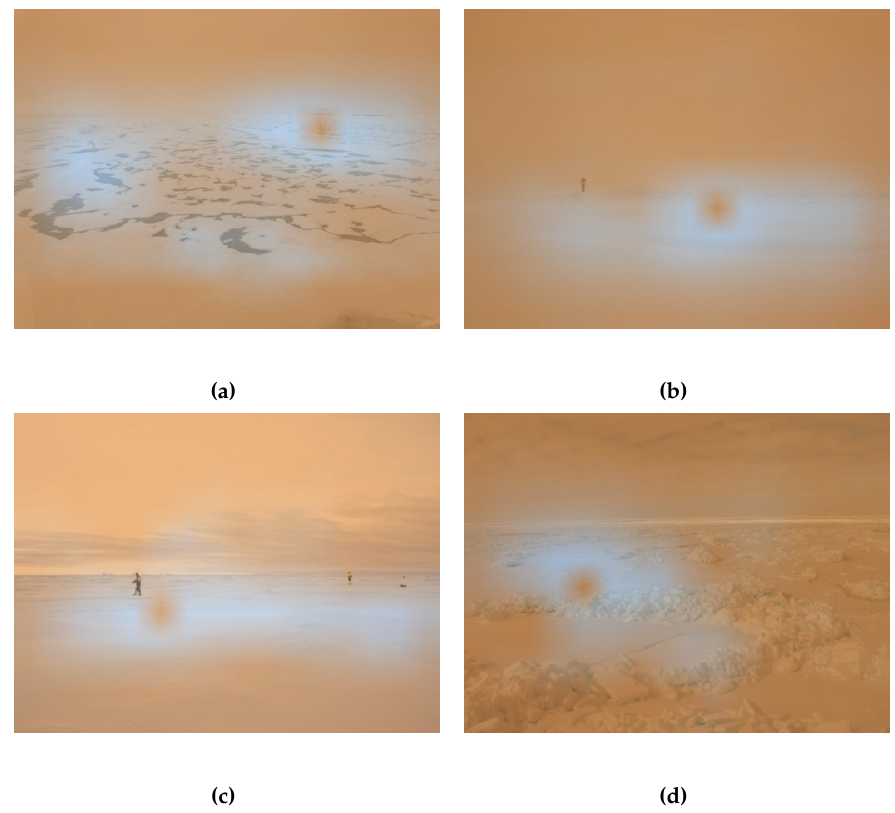
Figure 11. Grad-CAM images for the class ‘level ice‘. All four images were classified correctly by the network. Image rights: a: Lauren Farmer, b-c: SAMCoT Project, d: Knut Vilhelm Høyland